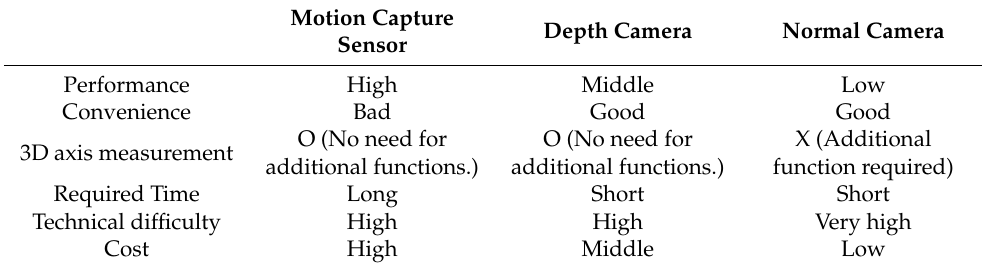
Table 2. The difference between human pose estimation methods. Motion Capture Depth Camera Normal Camera Sensor Performance High